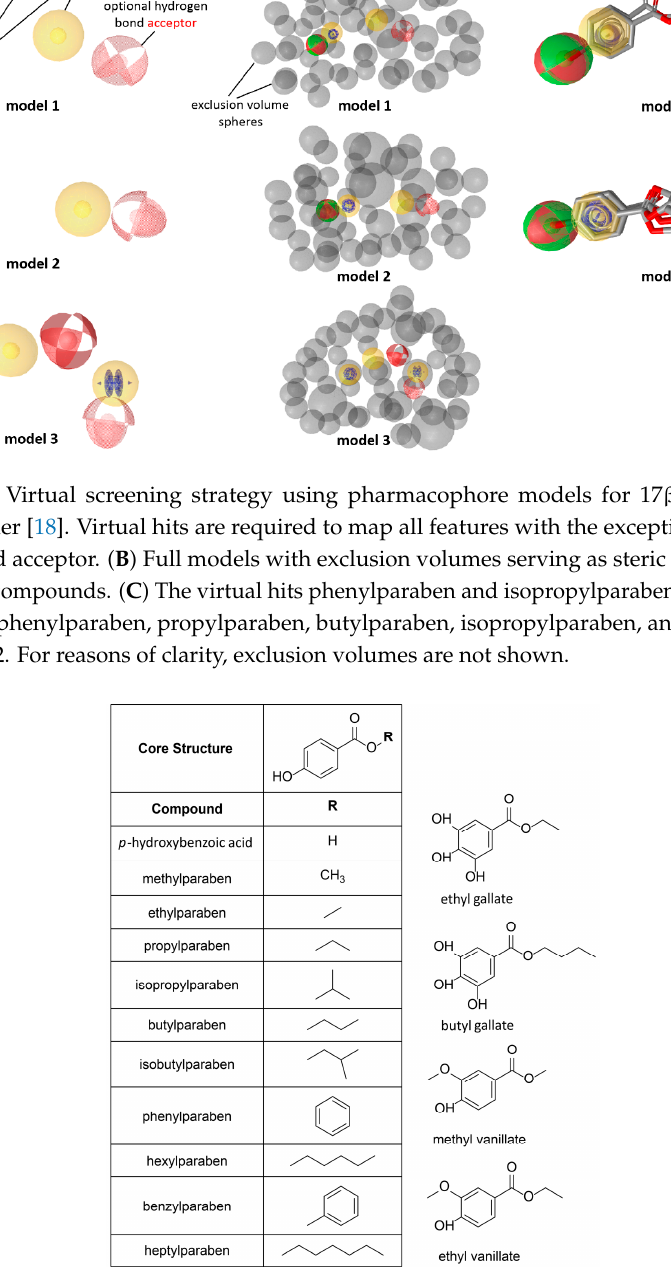
Figure 3. Chemical structures of the tested parabens, and vanillic and gallic acid derivatives.